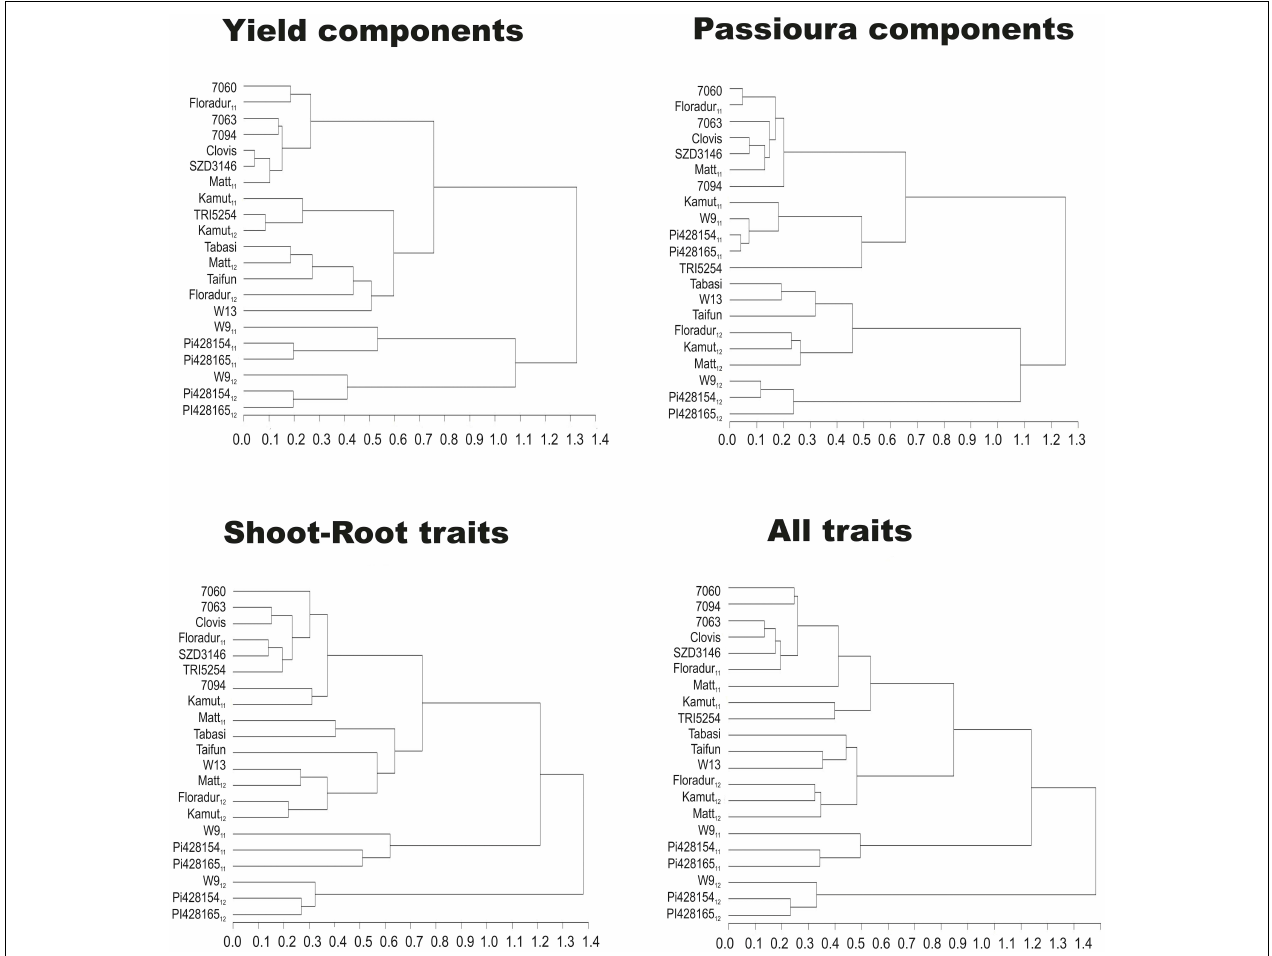
FIGURE 4 | Hierarchical clustering of wheat genotypes based on yield components, components of Passioura’s yield-water framework, phenological, morphological, physiological, and root traits related to components of Passioura’s yield-water framework, and all